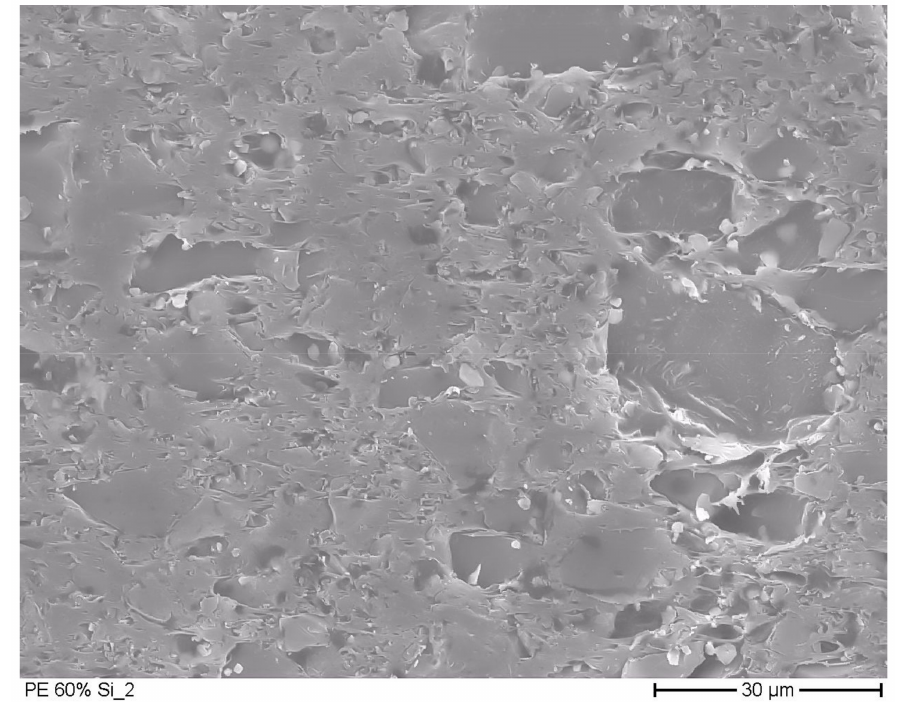
Figure 2. Electron microscopic picture of film with 0.6 g silica gel / g